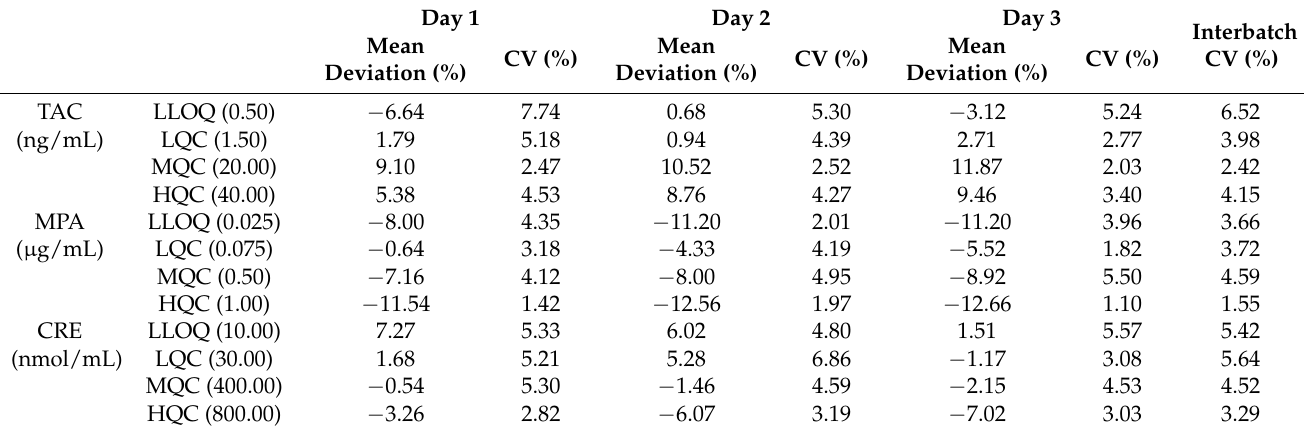
Table 2. Within- and between-batch accuracy and precision (N = 5).